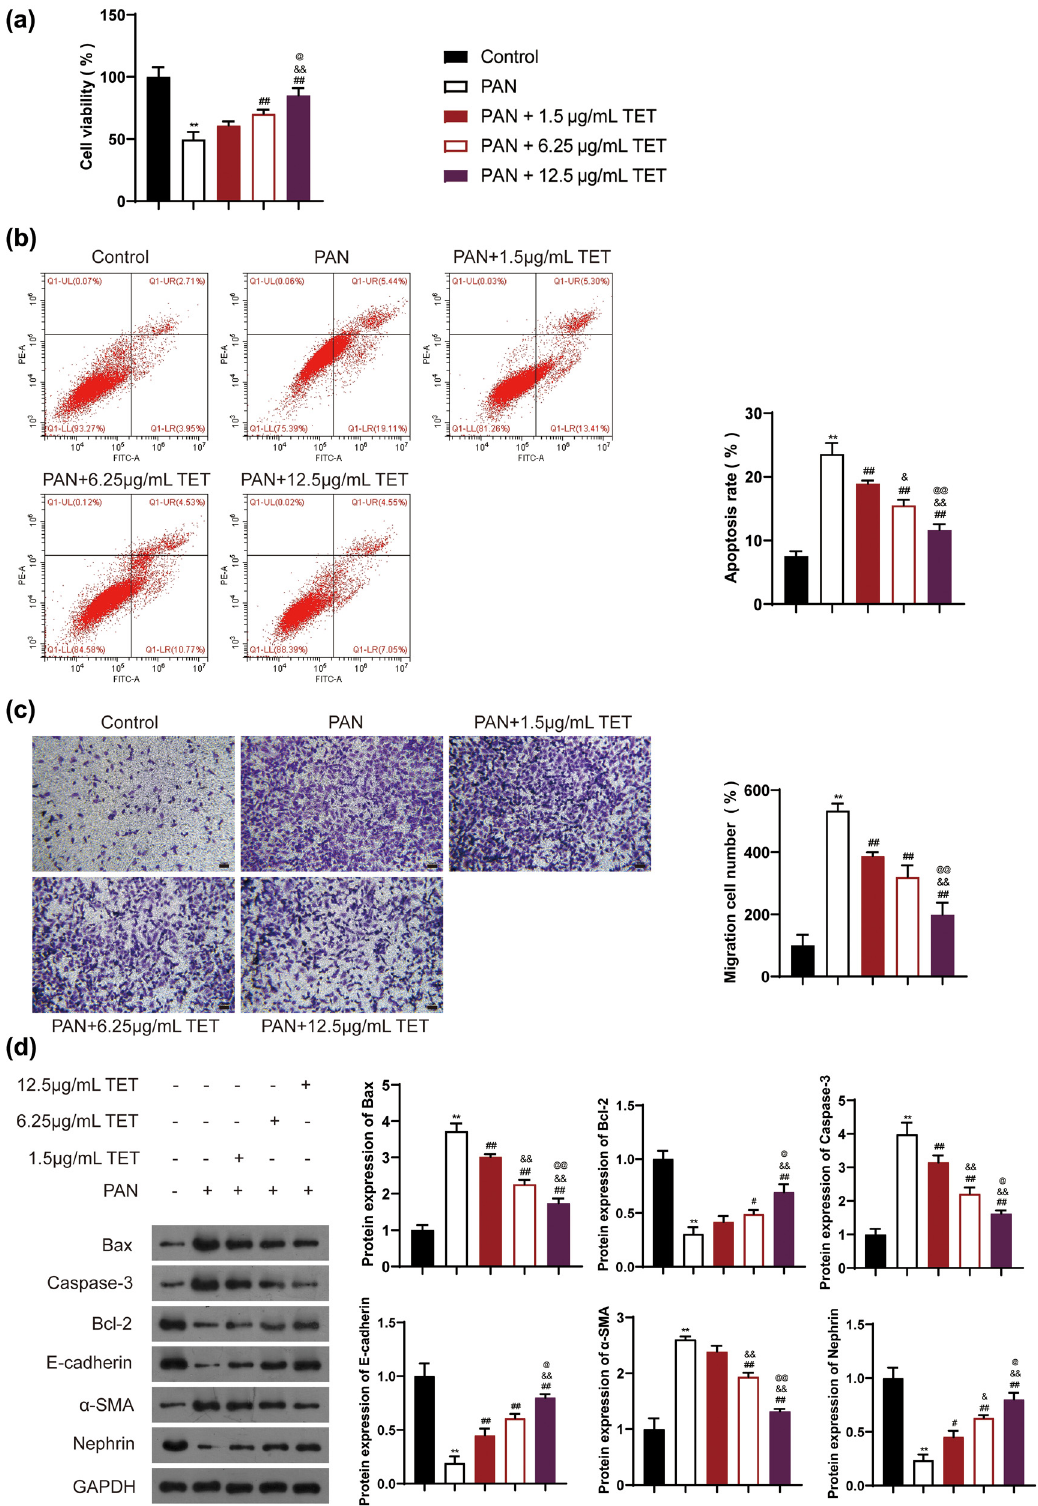
Figure 1: TET positively stimulated proliferation, and inhibited migration and apoptosis of injured HPC. ( a – c ) CCK - 8, fl ow cytometry, and Transwell assays detected the cell proliferation, apoptosis, and migration, respectively; scale bar = 50 μ m. ( d ) Western blot detected the levels of Bax, Bcl - 2, Caspase - 3, E - cadherin, α - SMA, and Nephrin. PAN - induced HPC were treated with TET ( 1.5, 6.25, or 12.5 μ g/mL ) . ** P < 0.01 vs control group; # P < 0.05, ## P < 0.01 vs PAN group; & P < 0.05, && P < 0.01 vs PAN + 1.5 μ g/mL TET group; @ P < 0.05, @@ P < 0.01 vs PAN + 6.25 μ g/mL TET